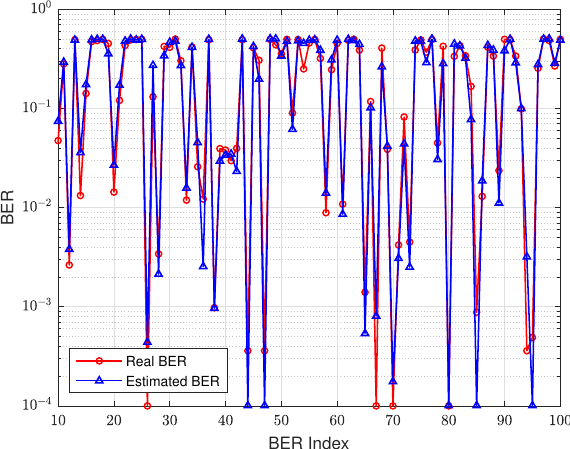
Figure 7. The segment of BER estimation in the test data set.